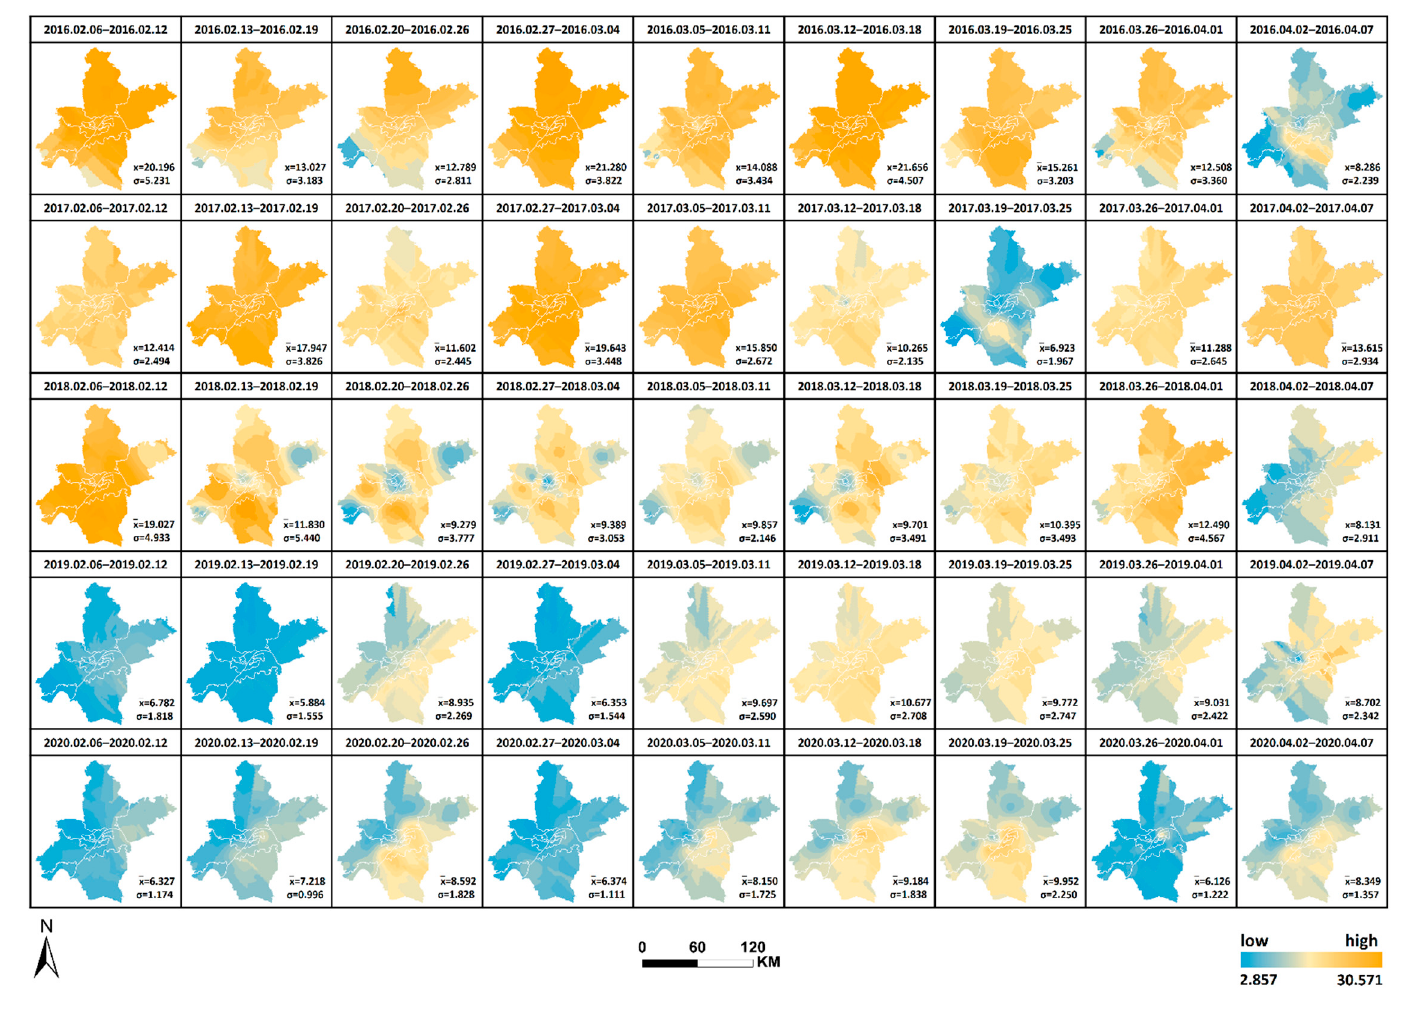
Figure 8. SO 2 interpolation chart from 2016 to 2020.